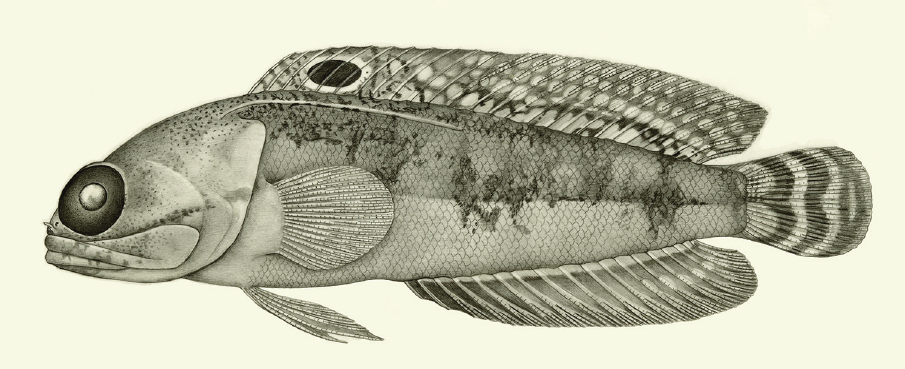
Figure 15. Opistognathus cuvierii , SU 52354, 102 mm SL, male, Bahia, Brazil. Drawn by Jack R. Schroeder; after Smith-Vaniz